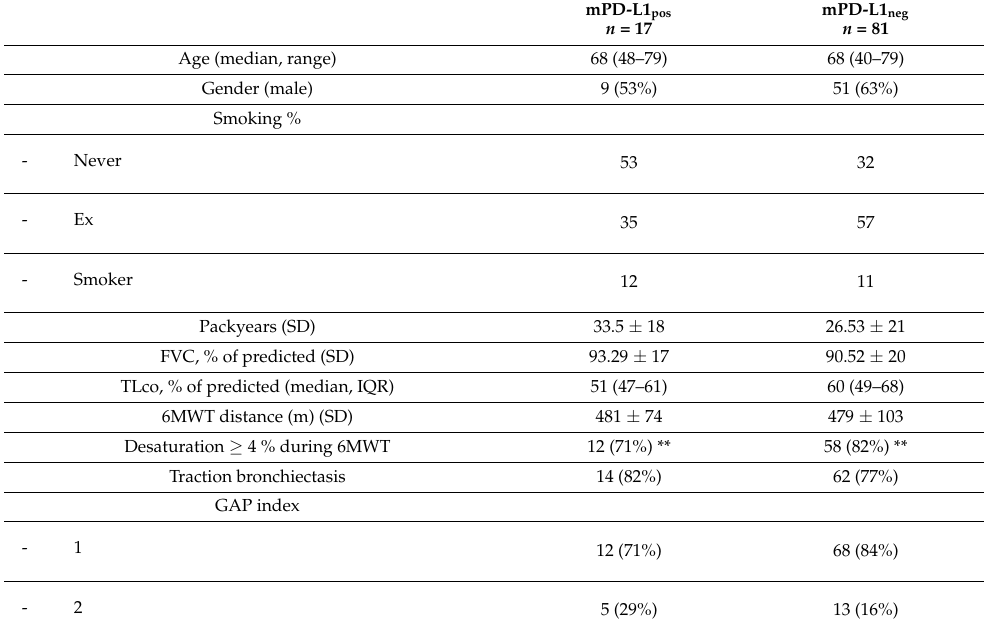
Table 3. Demographic characteristics of patients (IPF and non-IPF) with PD-L1-positive and PD-L1- negative membrane